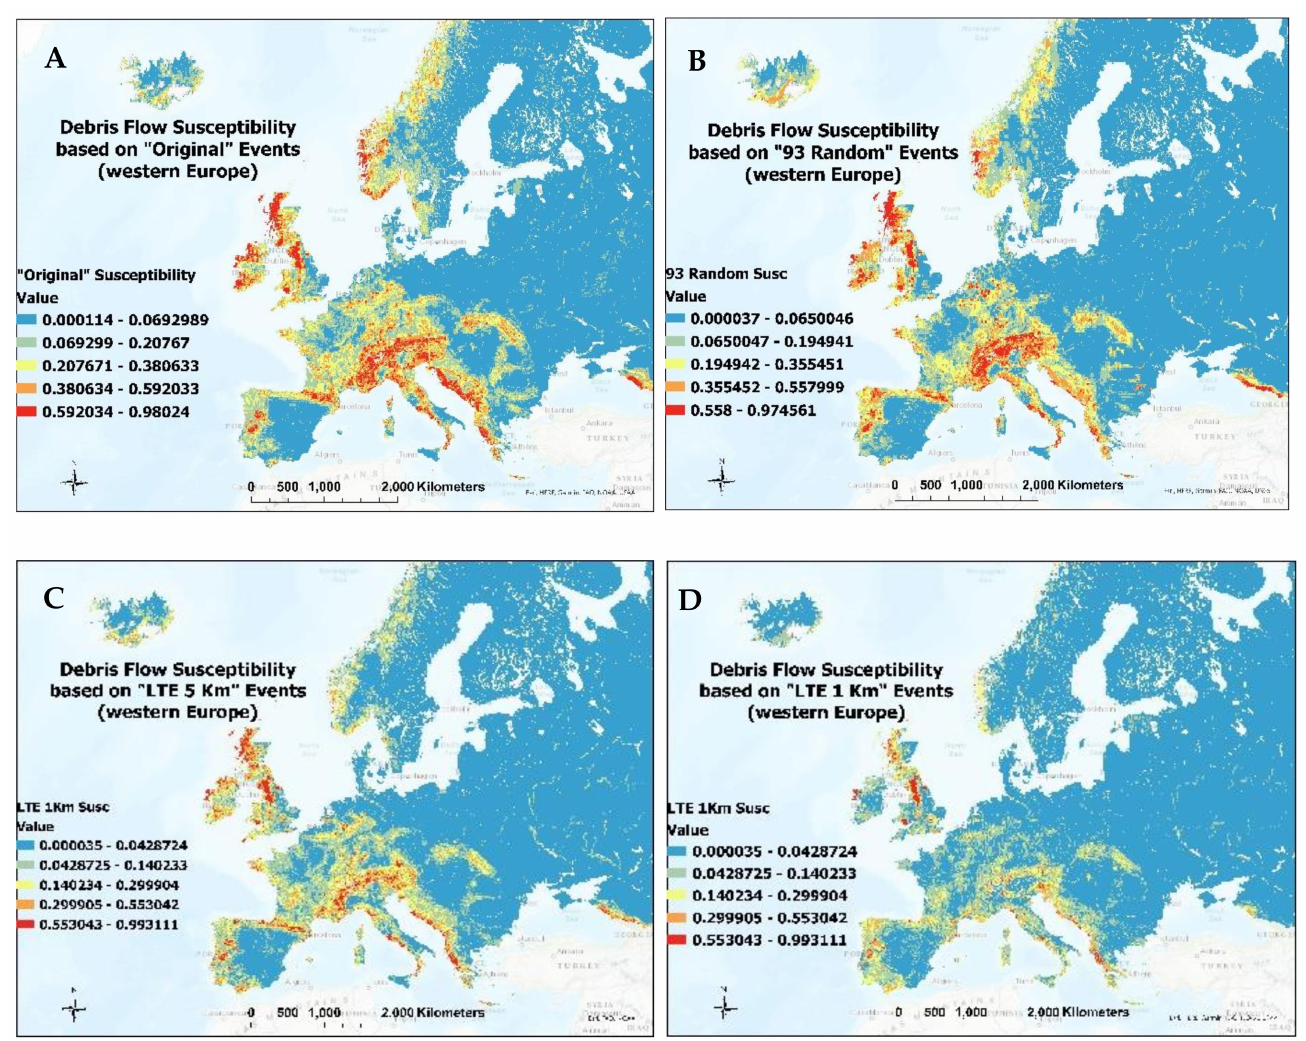
Figure 6. Debris flow susceptibility maps. ( A ). “Original”, ( B ). “93 Random”, ( C ). “LTE 5km”, ( D ). “LTE 1km”. Warmer colors represent higher susceptibilities. Base maps are from ArcGIS ® , the intellectual property of Esri, used herein under license. Copyright©